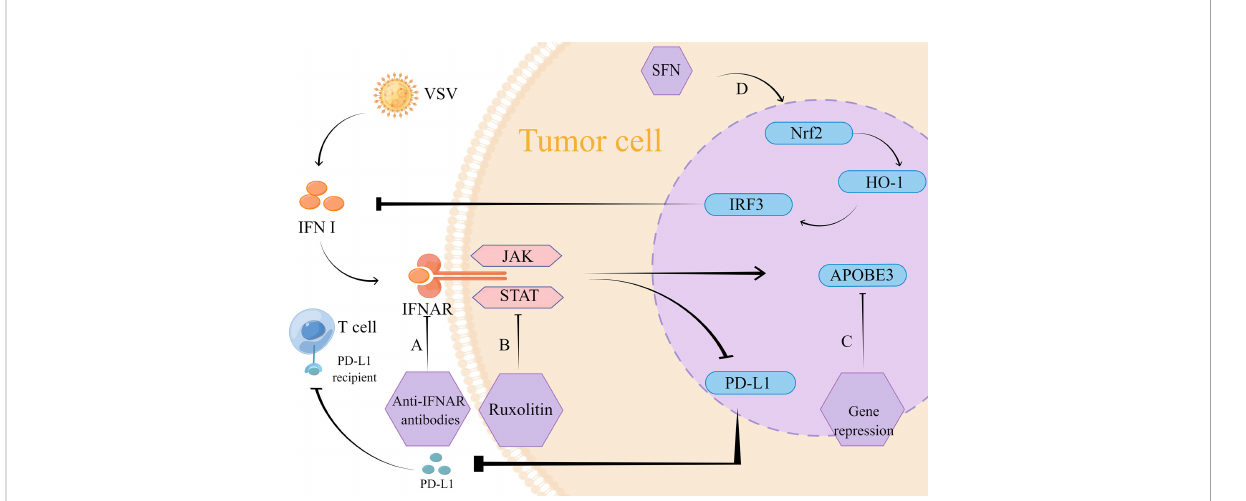
FIGURE 2 Mechanism of action of VSV therapy. (A) The intervention of monoclonal IFNAR antibody blocks the VSV-mediated IFN in fl ammatory pathway and reduces type I IFN-induced PD-L1 expression. Its low expression reduced PD-L1 binding to T cells, which thus exerted normal antitumor effects. (B) VSV strongly induced the JAK/STAT pathway, and inhibition of JAK/STAT using lusolidin prevented IFN-mediated antiviral response to VSV immune clearance, which promoted VSV replication and dissemination. Similarly, type I IFN-induced PD-L1 expression was reduced, thus preventing PD-L1 from binding to T cells and providing conditions for T cells to exert normal anti-tumor effects. (C) APOBEC3 gene expression is mediated by type I IFN, targeted inhibition of APOBEC3 gene can reduce IFN-mediated tumor resistance. (D) SFN through Nrf2/HO-1 pathway activates autophagy to inhibit IRF3 activity, which suppresses the type I IFN response. The inhibition of IFN response reduces the restriction of replication of VSV D 51, so VSV exerts its normal oncolytic